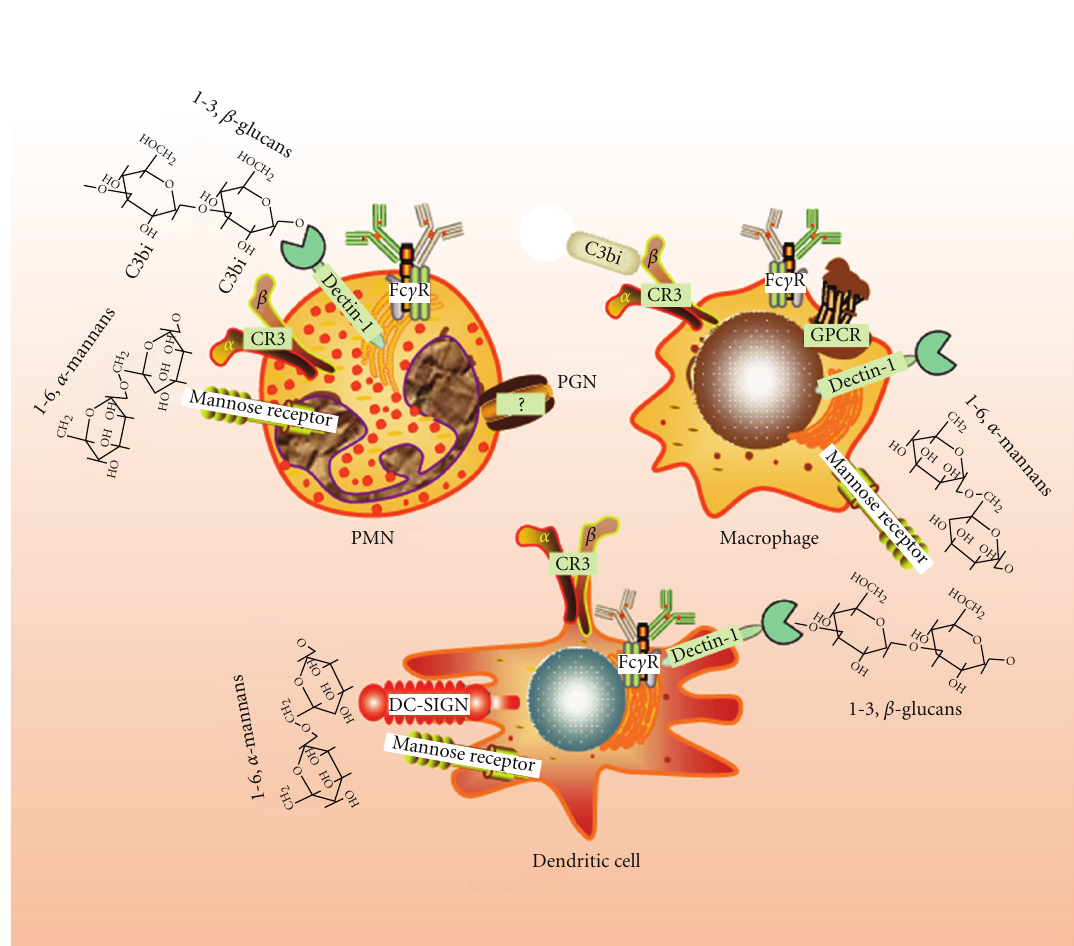
Figure 3: Cells and receptors involved in AA metabolism in the innate immune system. PMN respond to cooperative binding of dectin-1 and CR3, to the cross-linking of Fc γ R, to mannose-based PAMP, and to G-protein-coupled receptors (GPCR) in the presence of priming agents. The receptor involved in the response to PGN has not been characterized as yet. Macrophages express a similar array of receptors showing productive binding. In DC the most e ffi cient response is obtained by triggering dectin-1 and DC-SIGN by PAMP containing β -glucan and mannose polymers,